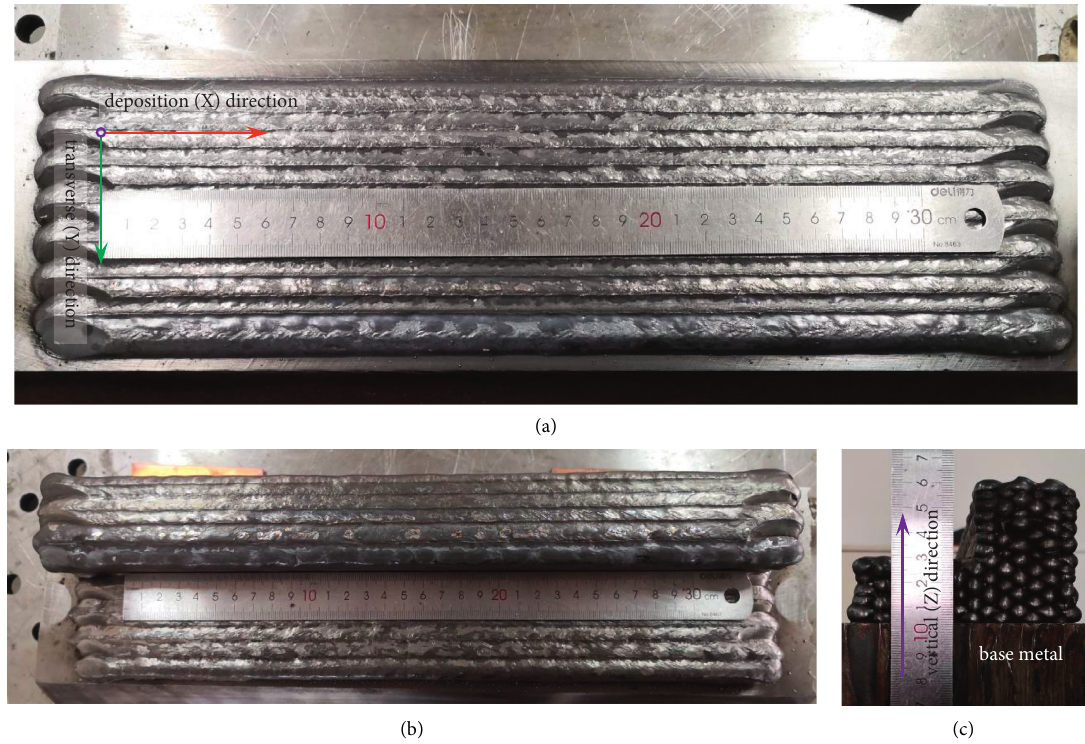
Figure 3: Macroscopic morphology of the deposit. (a) Top view after the first layer had been finished; (b) top and (c) side views of the made